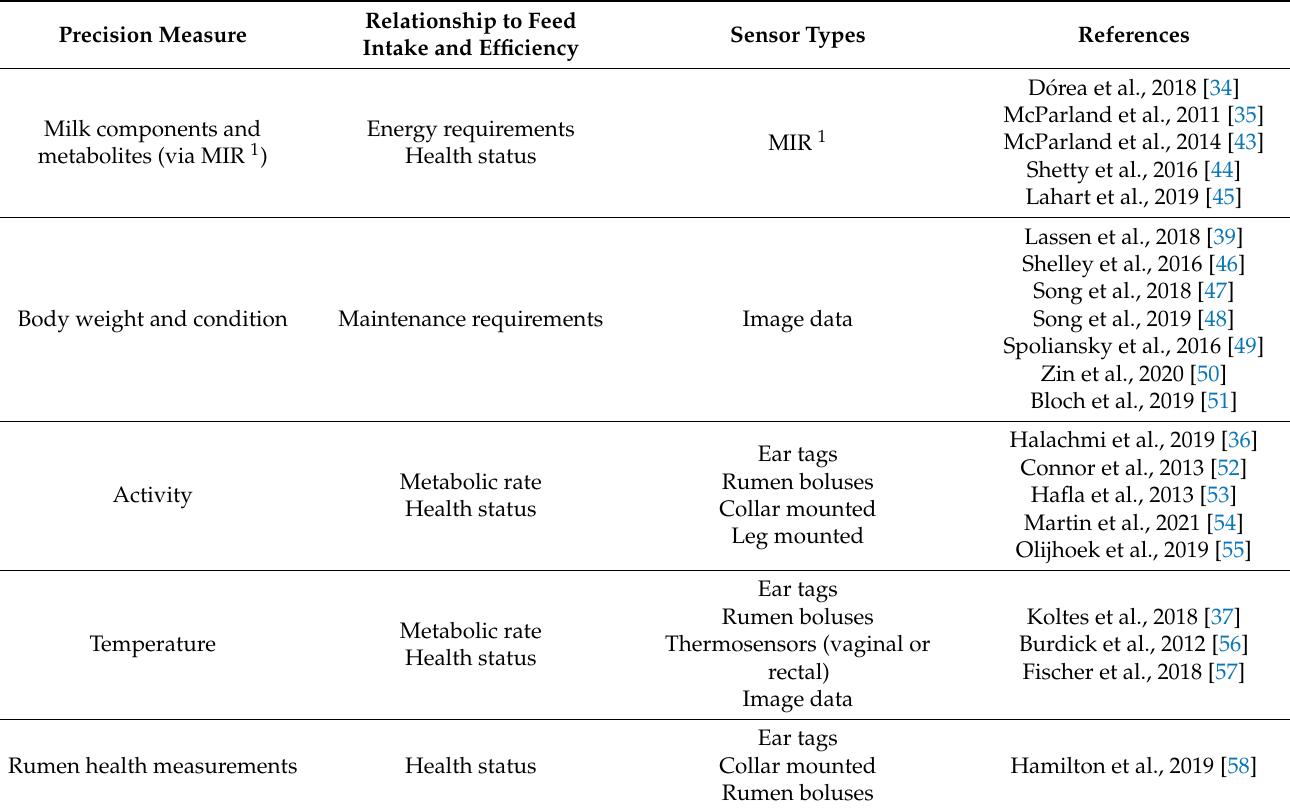
Table 1. Summary of precision measures that could be utilized in the improvement of feed intake and efficiency, including their relationship with feed intake and efficiency, sensors that collect the precision measures and research involving the precision measure and feed intake and/or